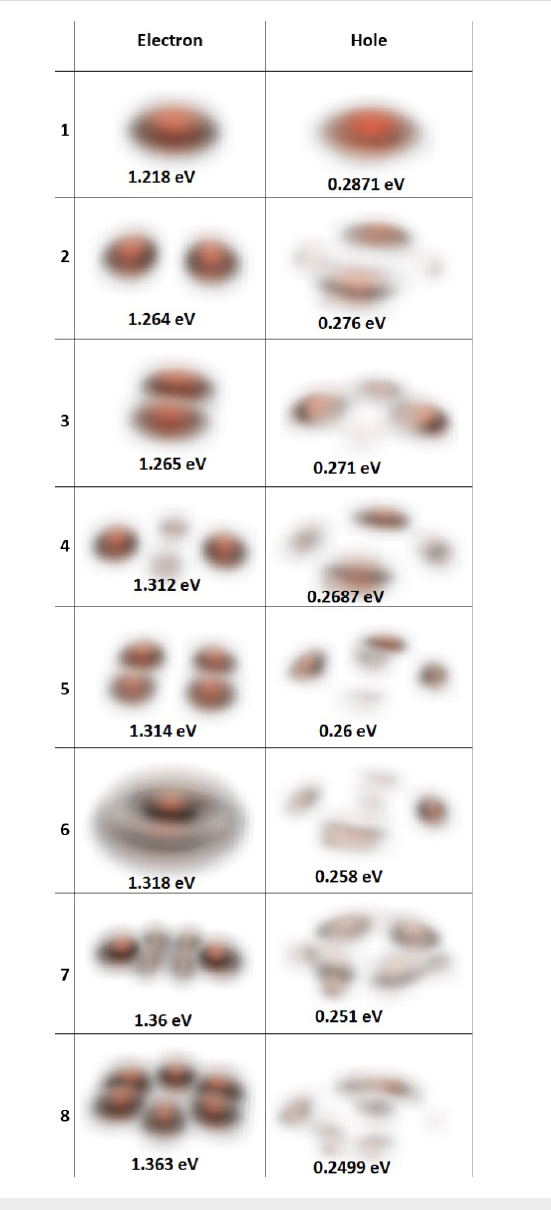
Figure 6: The magnitude square of the wave functions of the electron and hole states. Only the first eight electron and hole states are